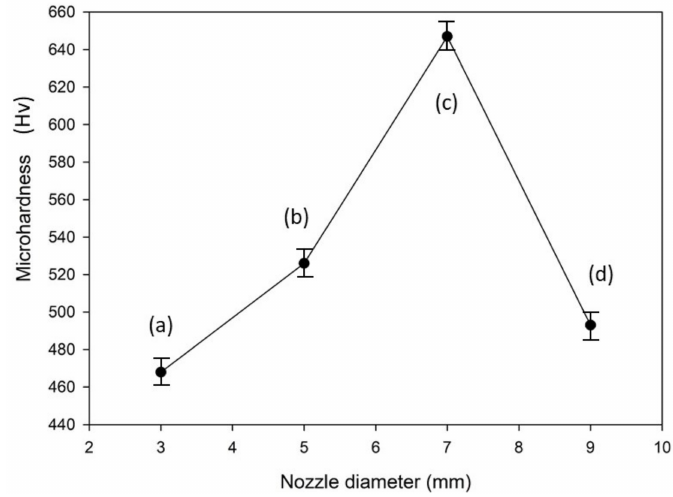
Figure 7. The micro-hardness of Ni–TiN coatings obtained at diverse nozzle diameters: ( a ) Nf = Φ 3 mm, ( b ) Nf = Φ 5 mm, ( c ) Nf = Φ 7 mm, ( d ) Nf = Φ 9